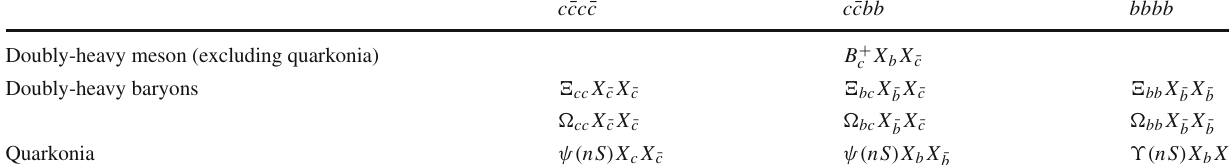
Fig. 17 Possible configurations of quark lines in DPS events with two pairs of charm quarks